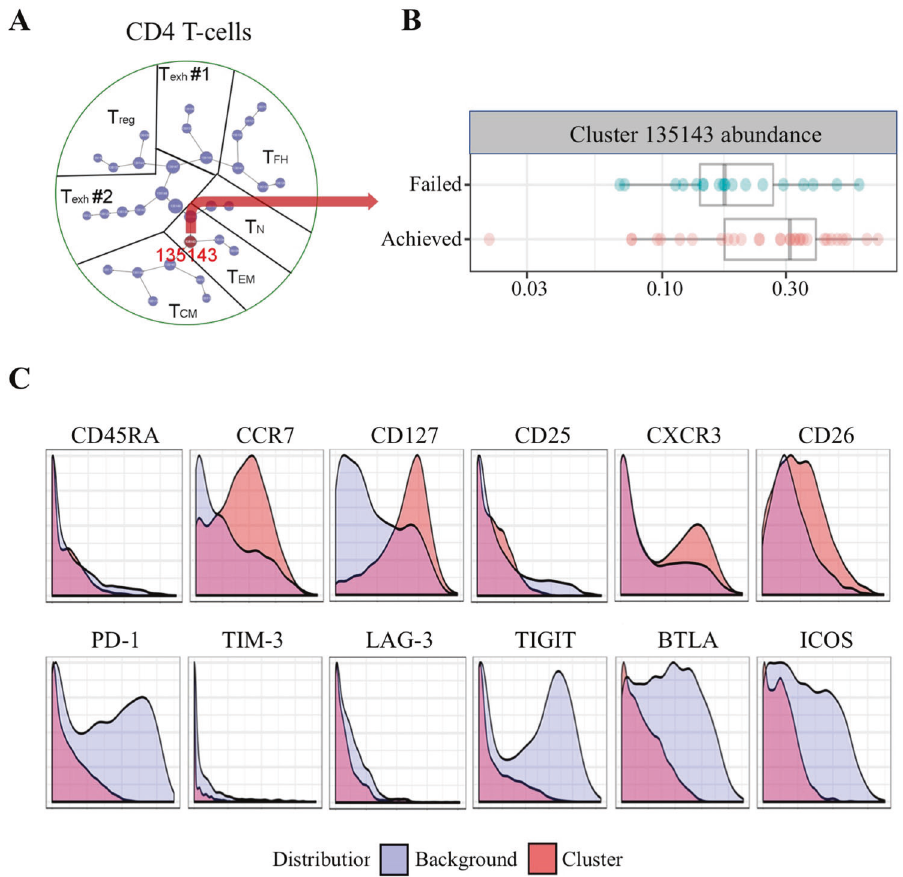
Fig. 3 Activated, nonexhausted central memory T cells play a crucial role in follicular lymphoma. A Plot showing hierarchical clustering of CD4 + T cells from 51 newly diagnosed FL patients who achieved ( N = 32) vs failed ( N = 19) EFS12/24. The red circle represents the cluster that differed between the two groups. Number in the circle indicates the cluster ID. B Graph showing the difference in cells abundance in cluster 135143 between patients who achieved ( N = 32) vs failed ( N = 19) EFS12/24. C Histogram plots showing the expression of indicated cell markers from the parent cluster (red) over the background (light blue) in cells from cluster